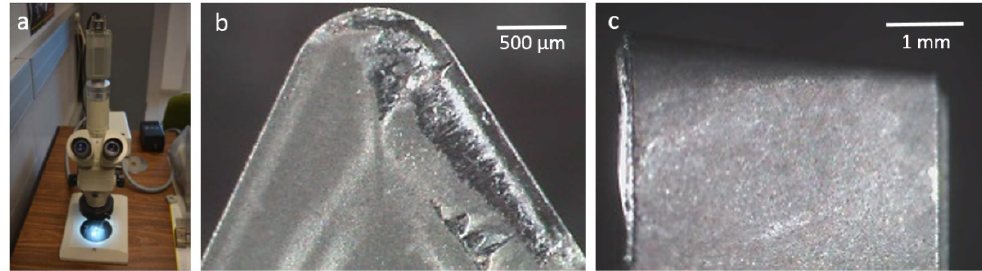
Figure 3. Tool wear monitoring: ( a ) SOM equipment; ( b ) tool rake face SOM image; ( c ) tool edge and flank face SOM image.